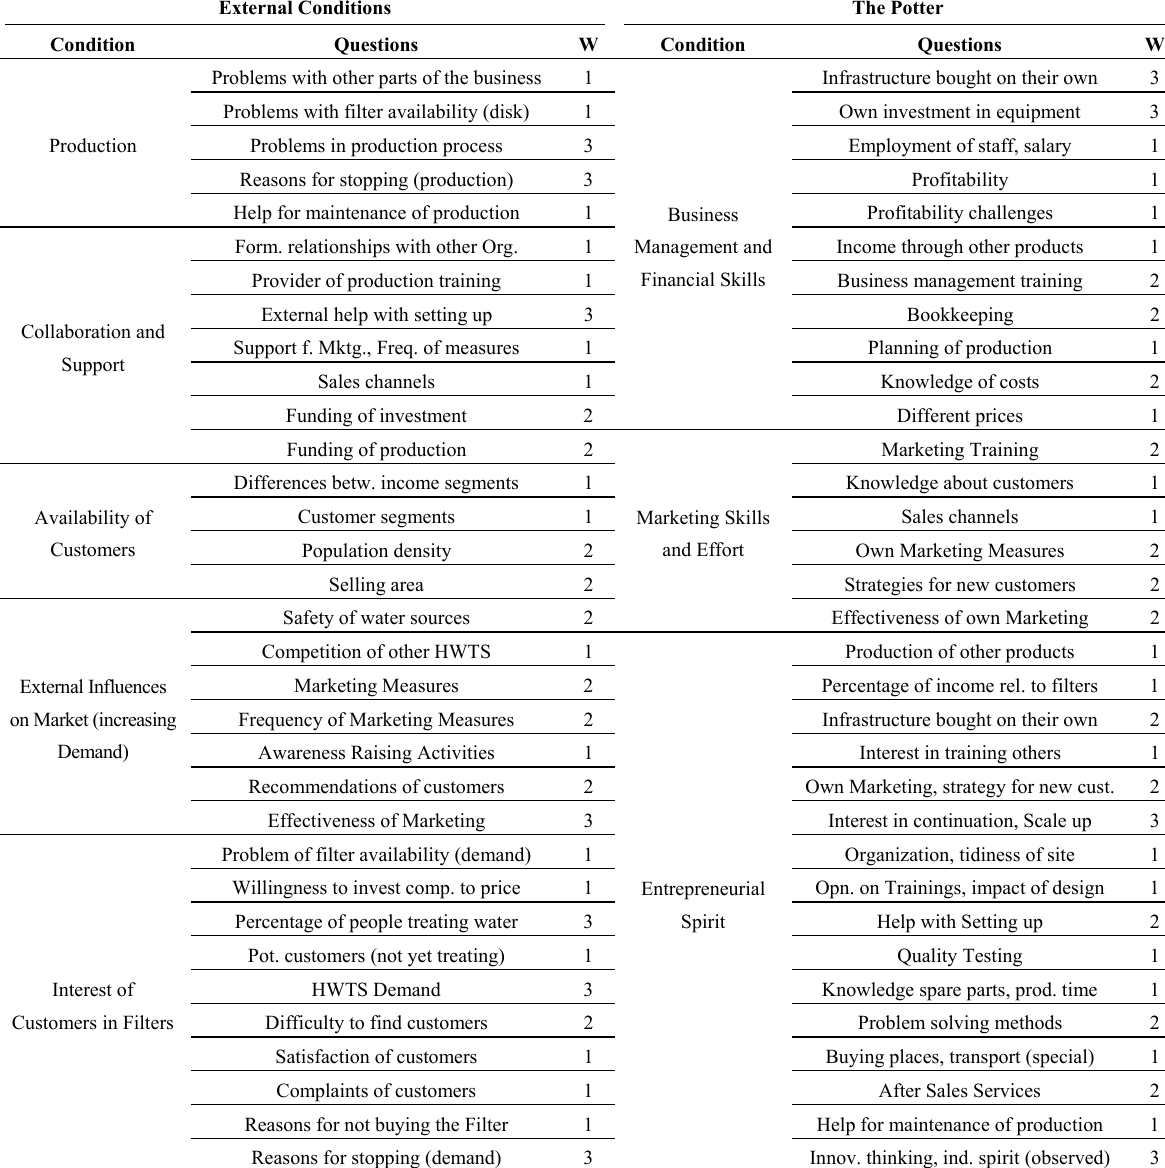
Table 1. Interview questions grouped into eight conditions and weighted according to their